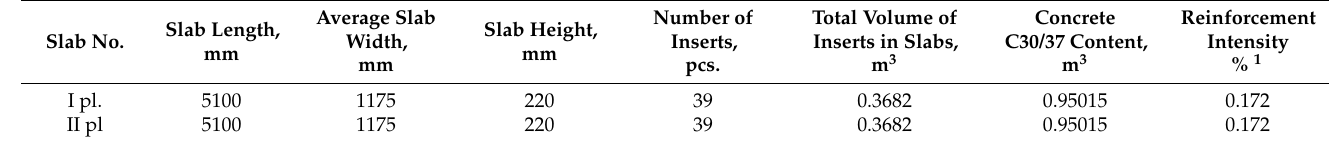
Table 1. The technical data of reinforced concrete floor slabs.